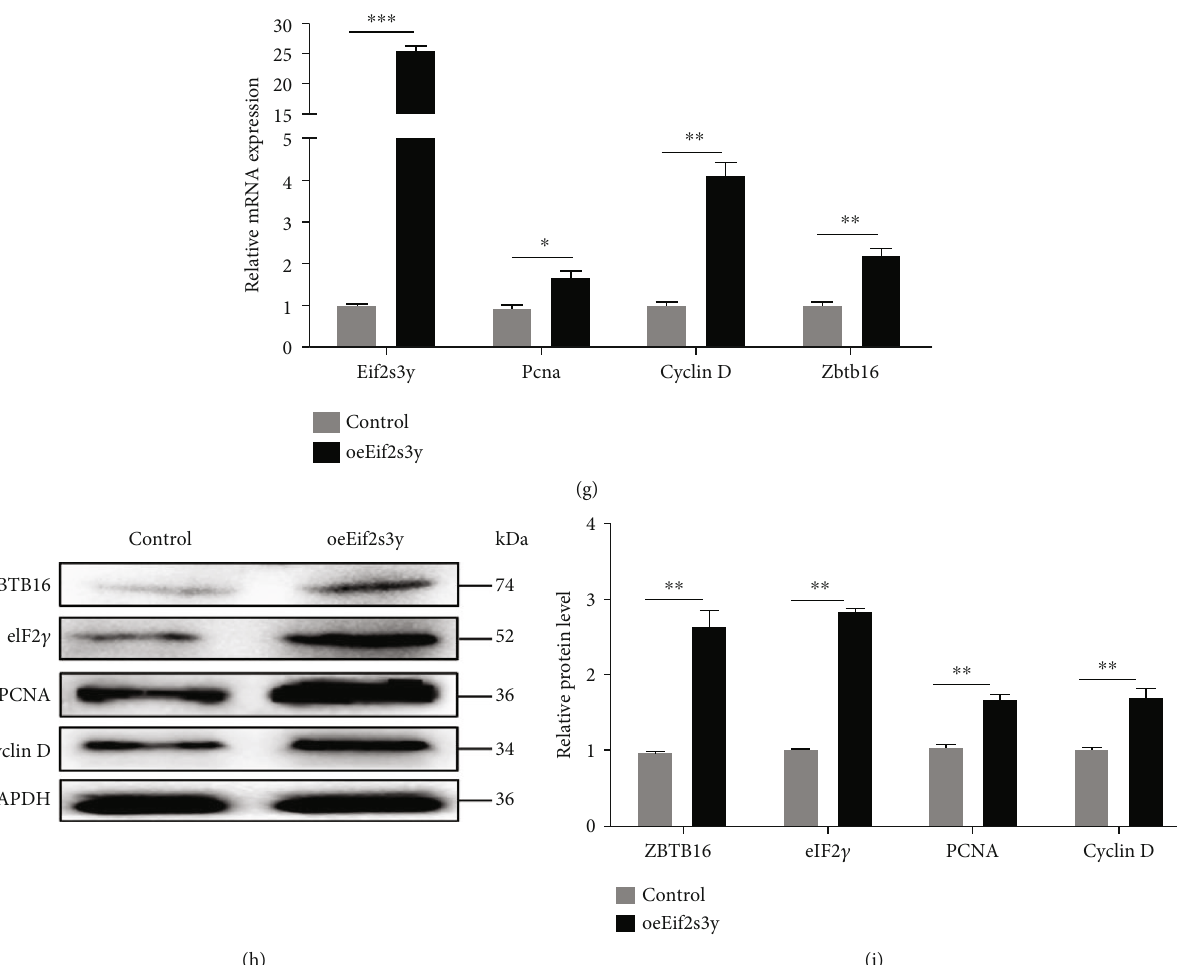
Figure 3: Overexpression of Eif2s3y promotes the proliferation of dairy goat SSCs. (a, b) The schematic of lentivirus plasmid pCDH-CMV- MCS-EF1-puro and pCDH-CMV- Eif2s3y -EF1-puro. (c) Typical images of SSCs transfected with Control-Vector (left) or oeEif2s3y -Vector (right). Scale bar, 200 μ m. (d) Proliferation curve of Control and oeEif2s3y SSCs and the results of population doubling time (PDT) determination. (e) EdU incorporation assay of Control (up) and oeEif2s3y (down) SSCs. Scale bar, 400 μ m. (f) The ratio of EdU-positive cells to total cells. The proportion of positive cells is positively correlated with the cell proliferation rate. (g) RT-PCR analysis of the expression levels of Eif2s3y , Pcna , Cyclin D, and Zbtb16 in dairy goat SSCs transfected with Control-Vector or oeEif2s3y -Vector. (h) Western blotting detected the protein expression of ZBTB16, eIF2 γ , PCNA, and Cyclin D in Control and oeEif2s3y SSCs. GAPDH was used as a loading control. (i) Gray intensity analysis of WB results normalized to GAPDH in (h). Data are presented as mean ± SD and are represented by three independent repetitions; ∗ P < 0 : 05 , ∗∗ P < 0 : 01 , and ∗∗∗ P < 0 : 001